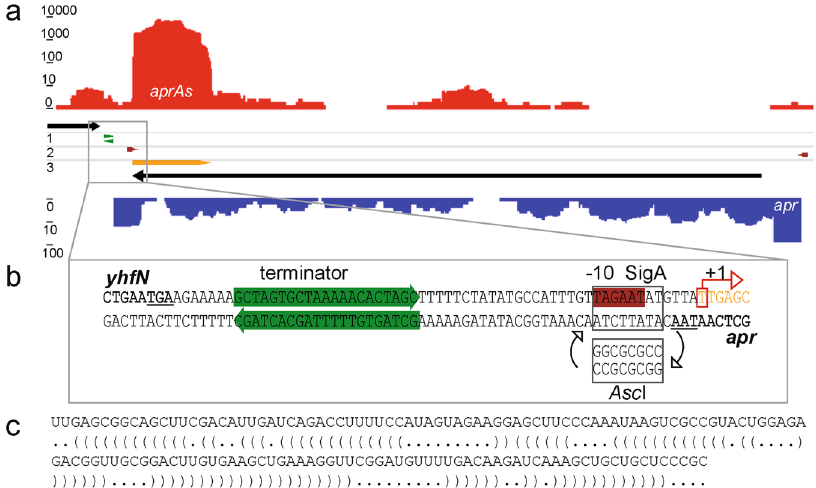
Figure 1. AprAs transcription profile, promoter region and sequence analysis. ( a ) Transcription profile of AprAs in the early stage of an industrial subtilisin production 25 . Transcriptome data were visualised in a logarithmic scale using TraV 56 . The red graph represents the transcription activity of aprAs and the blue of apr . The black arrow on the complementary strand represents the coding region of apr and the yellow arrow of aprAs . The dark red arrows represent the identified promoters and green arrows predicted transcription terminators. ( b ) Promoter region of aprAs . The − 10 box (TAGAAT) of the potential SigA promoter is highlighted in red and the exchanged sequence ( Asc I pattern) is given. Predicted transcription terminators are framed with green arrows. Protein coding sequences are shown in black bold letters and the stop codons are underlined. The aprAs coding sequence is given in orange letters and the experimentally determined transcription start site of AprAs 25 is framed in red. ( c ) AprAs sequence. The 144 base large AprAs sequence was analyzed via the RNAfold WebServer, using “The Vienna RNA Websuite” 55 . The calculation of secondary structures was possible and the optimal structure with a minimum free energy of − 51.9 kcal/mol is shown in dot-bracket